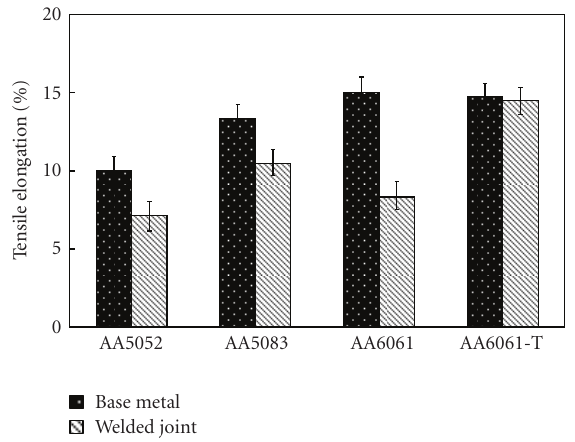
Figure 15: Tensile elongation of welded joints of AA5052, AA5083, and AA6061 alloys together with that of base metals. T: Heat treated; aged after welding.